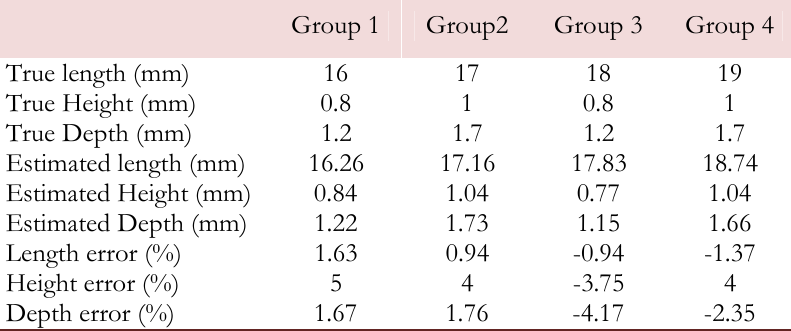
Table 4: Identification of defect using